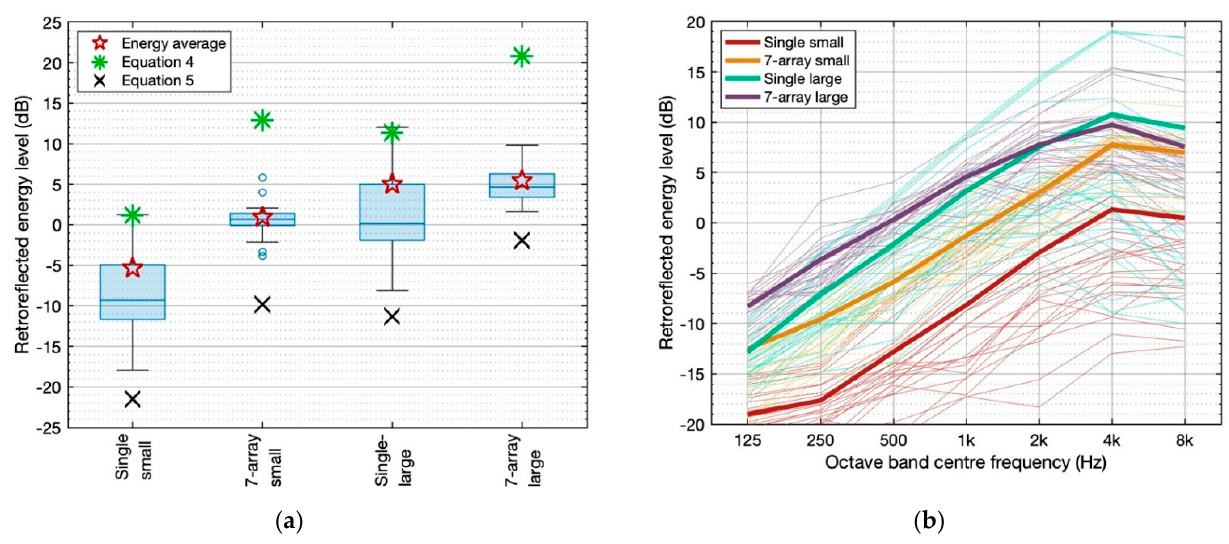
Figure 15. Retroreflected energy levels for 25 collocated source-receivers in a 2.4 × 2.4 m square offset from parabolic trihedral reflector configurations: ( a ) speech-A-weighted distributions, with red star-markers showing energetically averaged values; ( b ) octave band spectral distribution, showing individual values (thin lines) and energetically averaged values (thick lines). Values for Equation (4) (coherent pressure focus) and Equation (5) (energy focus) are calculated from the solid angle of the reflector for a source-receiver aligned with the reflector’s centroid.